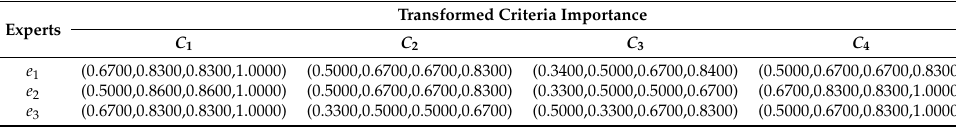
Table 8. Transformed information of fuzzy criteria weights ˜ W h